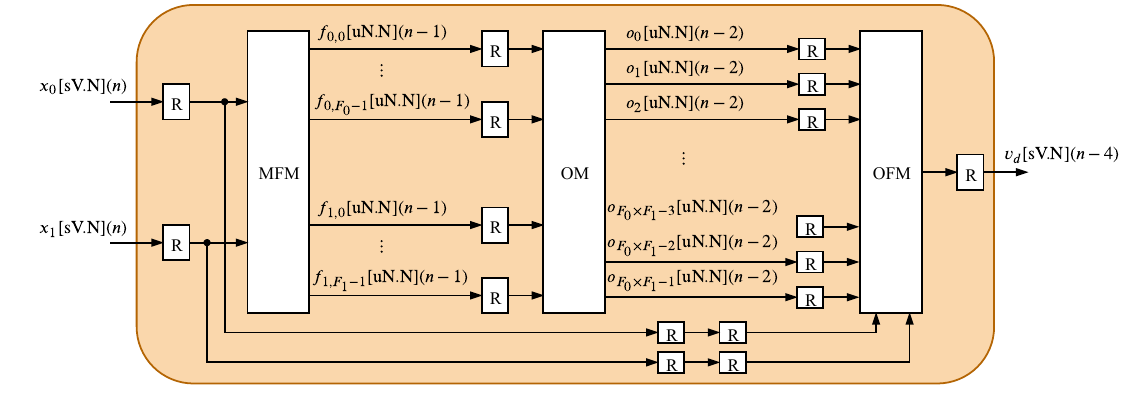
Figure 5. Hardware architecture of TS-FIMM Pipeline